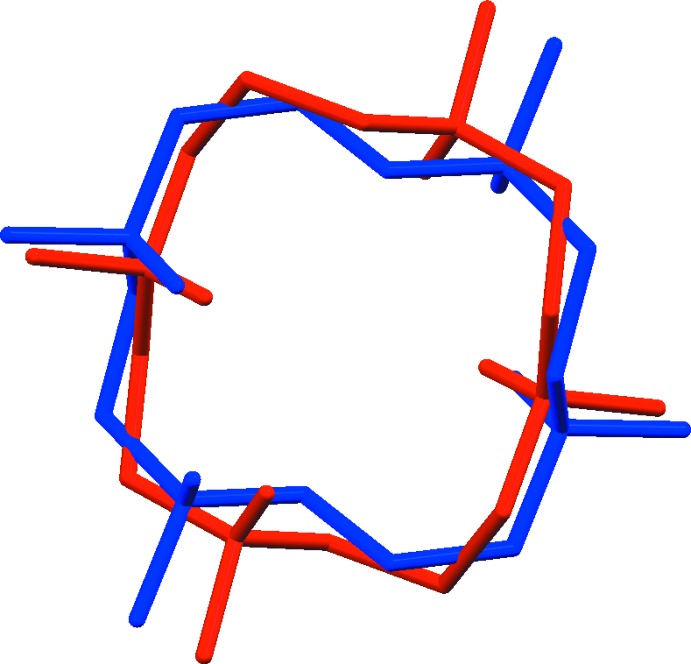
Overlay of the two macrocyclic cations in (I) (blue) and in [H4TMC](ClO4)2Cl2 (red).